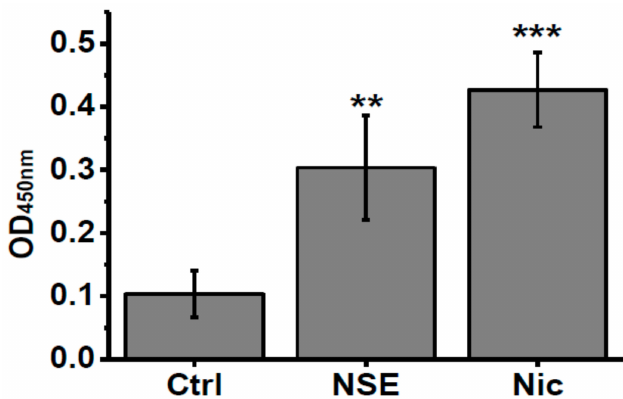
Figure 4. Level of IL-6 in the blood sera of α 7- / - mice under the e ff ect of either nicotine or NSE. Each column corresponds to M ± SD, n-5. ** p < 0.005; *** p < 0.0005 compared to non-treated α 7- / - mice (Ctrl).